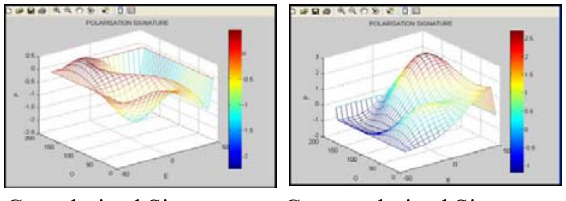
WaterbodyCo-polarized Figure 3.4(a): Polarimetric response of